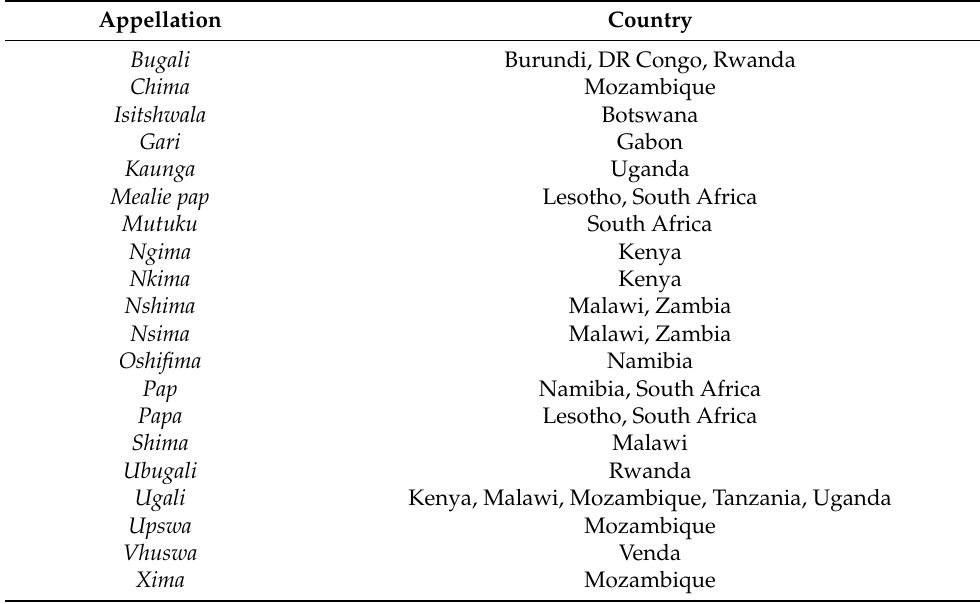
Table 1. Appellations of the same staple food in different African